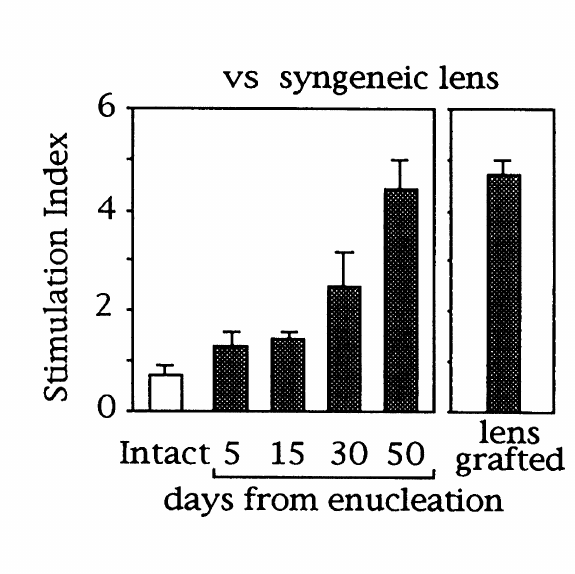
FIGURE 4 Responses of splenocytes from flogs enucleated after metamorphosis. Splenocytes were prepared from intact adult frogs th th th th or from enucleated flogs on the 5 15 30 and 50 day after both eyes had been removed. Splenocytes from adult flogs grafted with a syngeneic lens on the 30 th day after eye removal were also cultured with another syngeneic lens on the 50 th day after lens grafting. The number of BrdU-incorporated proliferating spleno- cytes is shown as the relative proliferating rate (Stimulation Index) on the 5 th day. The actual proliferating cells in the control culture was 3.21%, where the stimulation index was 1. Values represent mean _+ SD obtained from three replicate cultures